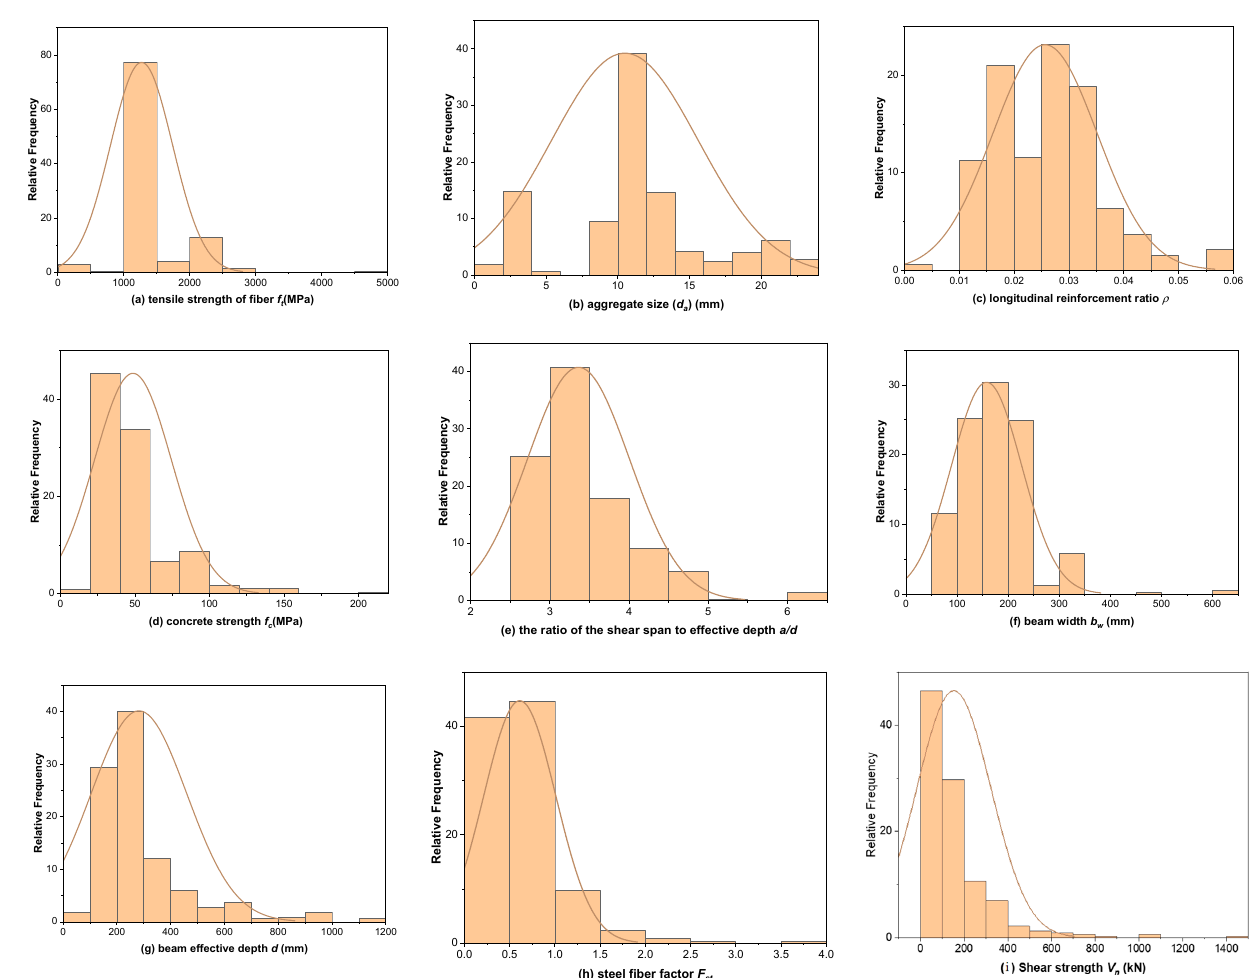
Figure 2. Relative frequency distributions for the input and output variables.